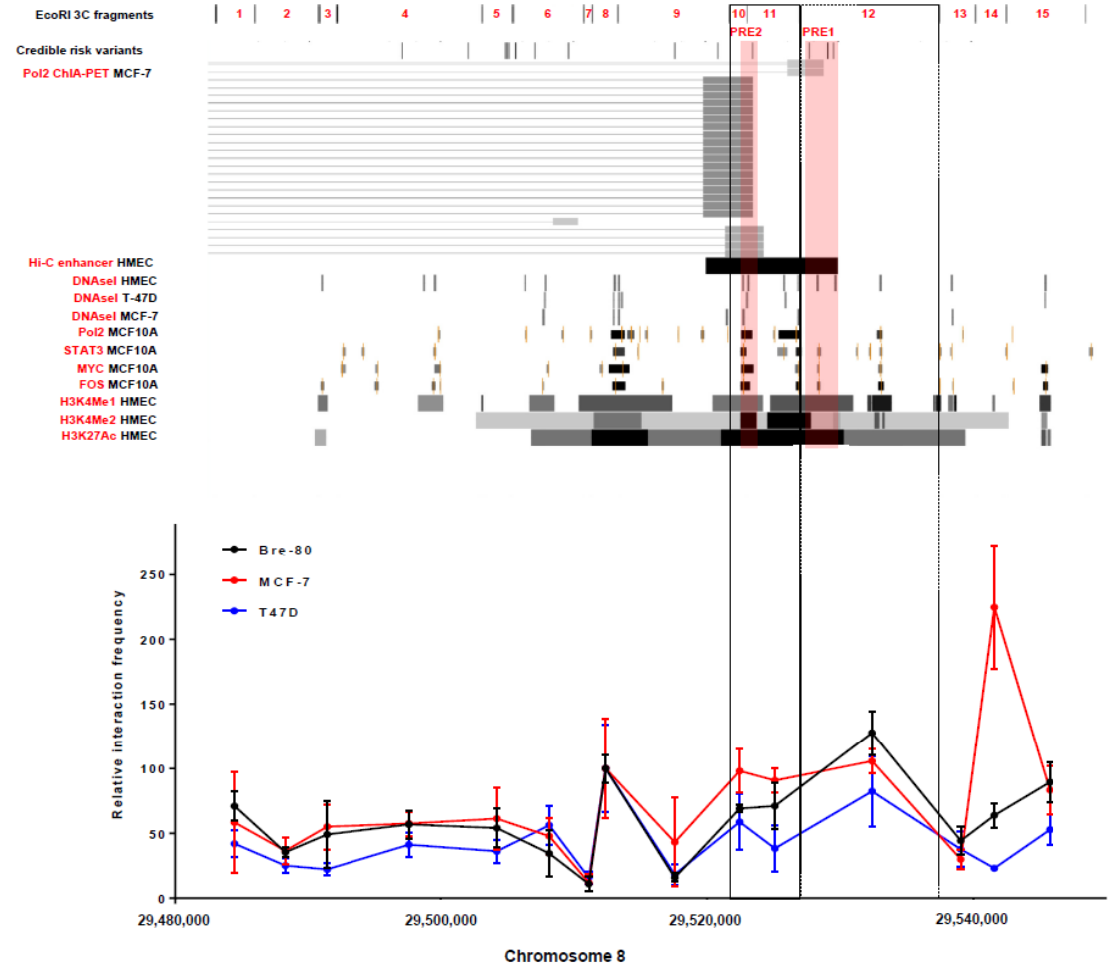
Figure 1. Candidate risk variants (CCVs) were located in putative regulatory elements (PREs) that interact with the DUSP4 promoter. The figure shows the 8p12 breast cancer risk locus annotated with breast cell functional genomic data and 3C analyses of interactions between EcoRI fragments and the DUSP4 promoter region (located ≥ 300 kb upstream) in Bre-80, MCF-7, and T-47D cells. Functional genomic data from normal mammary epithelial cells (HMEC and MCF-10A) and breast cancer cell lines (MCF-7 and T-47D) in this figure include Hi-C analysis [7] and ENCODE data accessed from the Univeristy of California Santa Cruz Genome Browser: RNA polymerase II chromatin interaction analysis by paired-end tag sequencing (ChIA-PET), epigenetic marks characteristic of enhancers (DNaseI hypersensitivity sites and H3K4Me1, H3K4Me2, and H3K27Ac histone modifications), and transcription factor binding (Pol2, STAT3, MYC, and FOS). Notably, all ChIA-PET anchors and the predicted Hi-C enhancer looped to the DUSP4 promoter. For the 3C analyses, interaction frequencies were normalised to those of fragment 8, a common peak of interaction in all three cell lines. Interaction frequencies from three independent biological replicates are shown (error bars represent standard error of the mean). Fragments demonstrating interaction peaks and encompassing PREs with CCVs are bounded by boxes. The PRE regions cloned for reporter gene analysis are highlighted in pink.